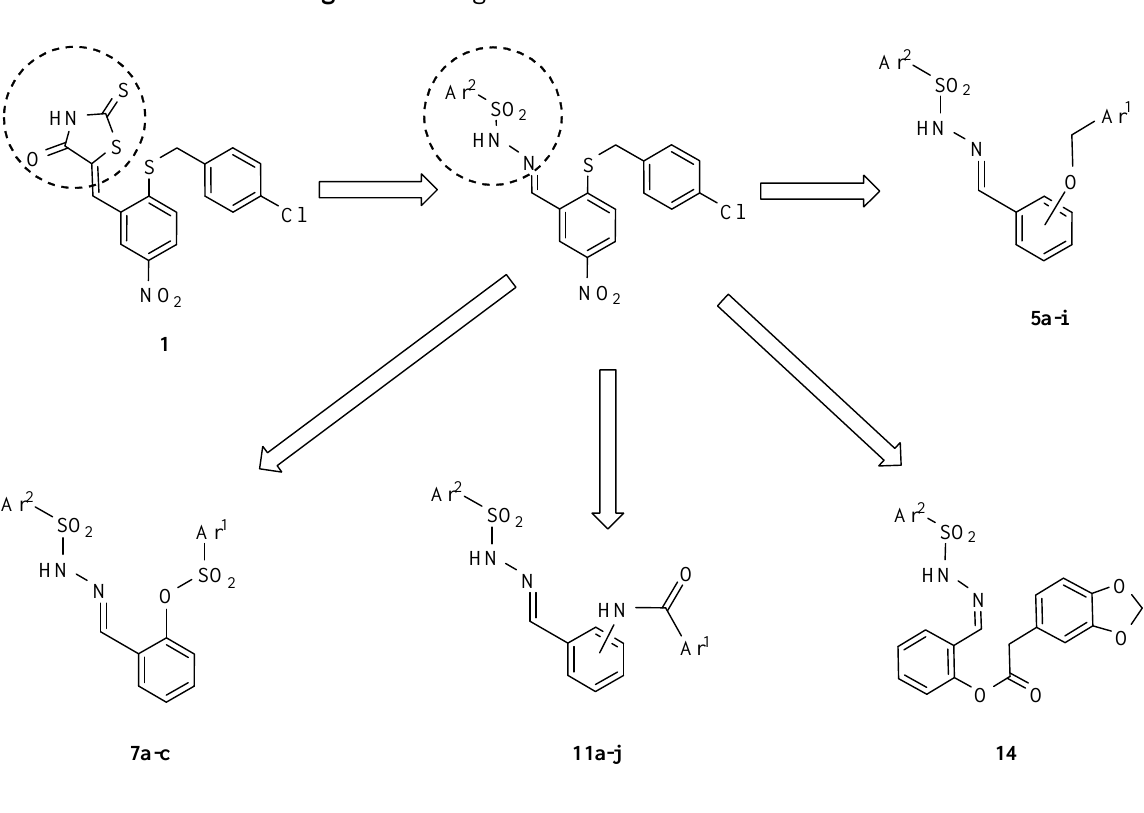
Figure 3. Design of novel MurC